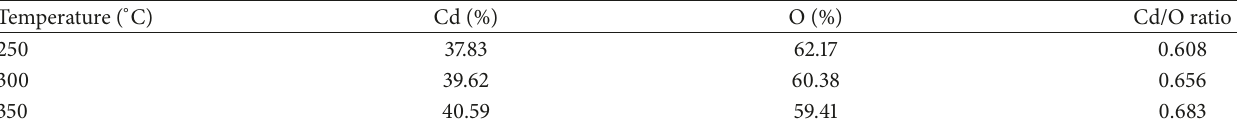
Table 1: Elemental analysis by EDX (atomic % of CdO thin films at three different decomposition temperatures).